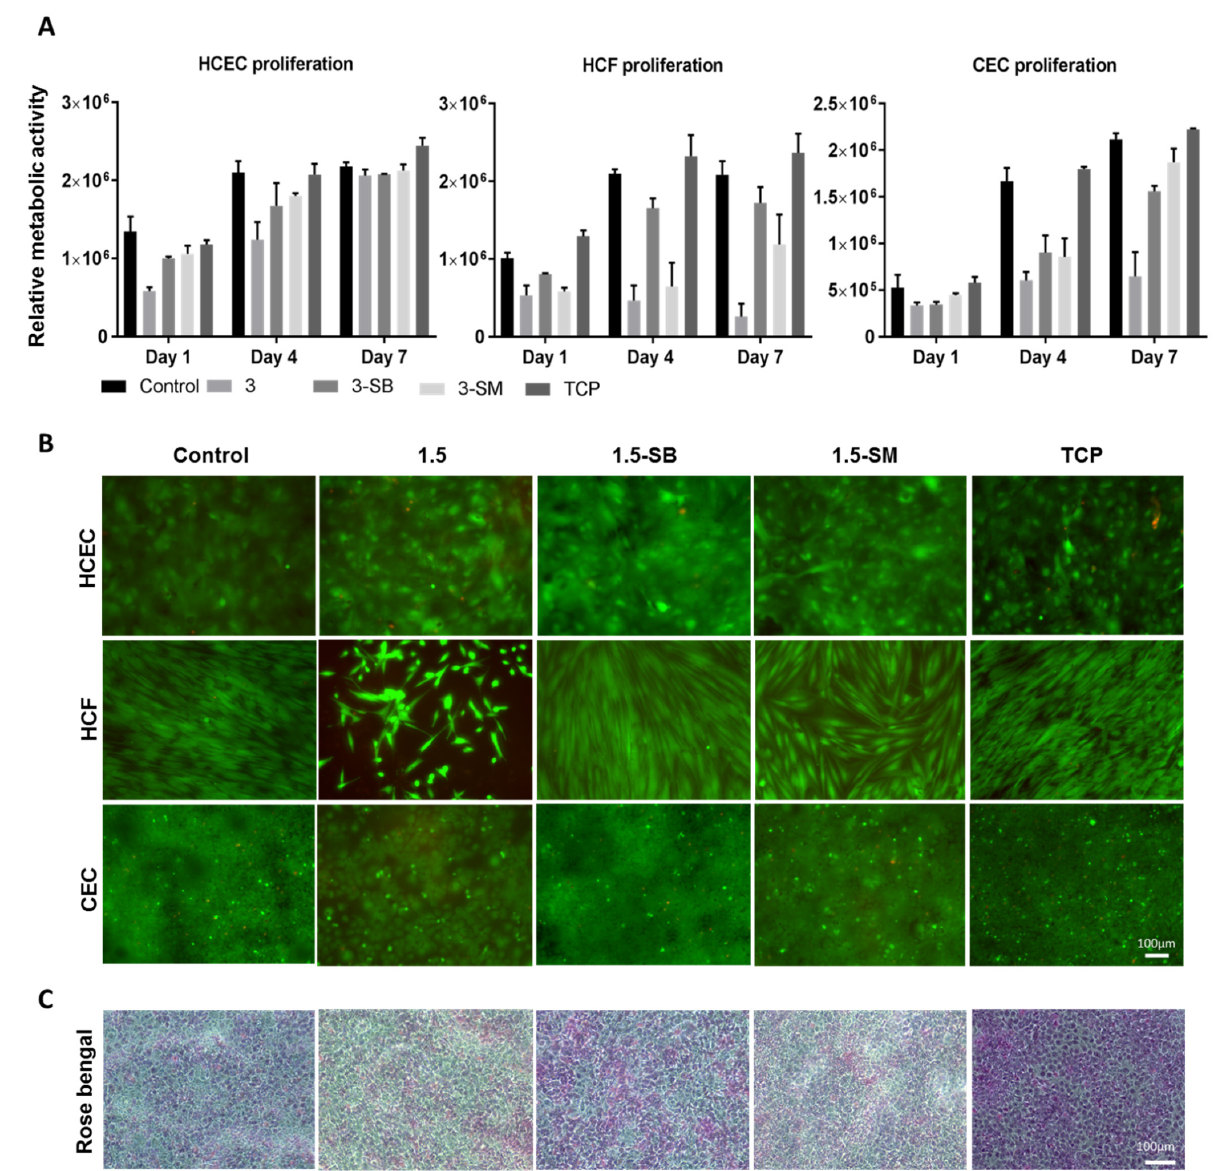
Figure 4. Biocompatibility studies of hydrogels 3 with three corneal cell types. ( A ) Metabolic activity study with individual cells at different time points, compared between hydrogels, with tissue culture plate (TCP) as a positive control. Quantitative results were reported as the mean ± S.D. (arbitrary unit) from three independent samples at each time points. ( B ) Live/dead staining of human corneal epithelial cells (HCEC), human corneal fibroblasts (HCF) and human corneal endothelial cells (CEC) on PFGT 3 hydrogels before and after post-crosslinked chemical treatment, compared with control hydrogel. All the images were taken at 7 days of cell culture. ( C ) Rose Bengal assay showed a normal pattern of stratification of the corneal epithelial cells, exhibiting multiple non-stained areas where the stratified epithelial barrier function excludes the dye. Scale bars are 100 μ m.